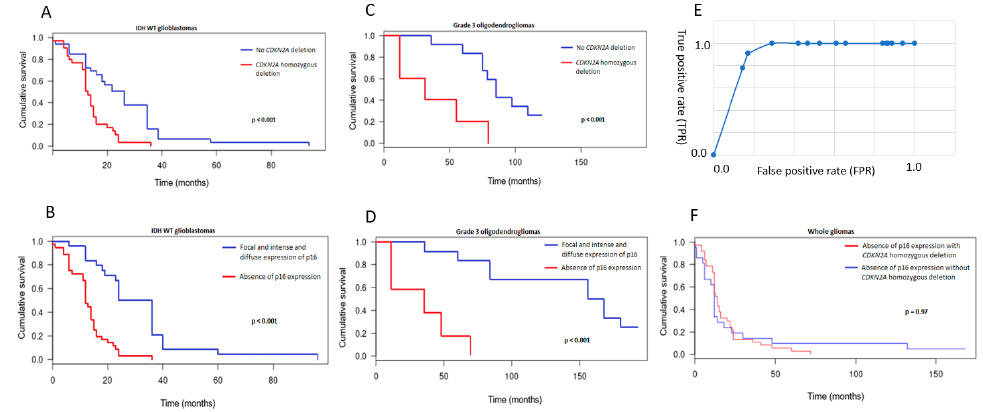
Figure 3. Kaplan–Meier survival curves according to CDKN2A homozygous deletion in IDH -wt Figure 3: Kaplan–Meier survival curves according to CDKN2A homozygous deletion in IDH- wt gli- glioblastomas ( A ). Kaplan–Meier survival curves according to the pattern of p16 expression in IDH -wt glioblastomas ( B ). Kaplan–Meier survival curves according to CDKN2A homozygous deletion in oligodendrogliomas (grade 3) ( C ). Kaplan–Meier survival curves according to the pattern of p16 expression in oligodendrogliomas (grade 3) ( D ). ROC analysis plot of the performance of p16 IHC